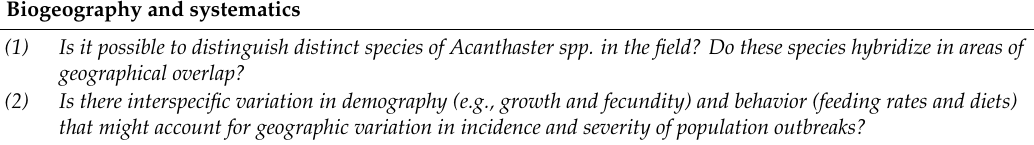
Table 2. New questions about crown-of-thorns starfish, intended to stimulate future research. These are additional to unresolved questions that were posed by Moran [21] (Table